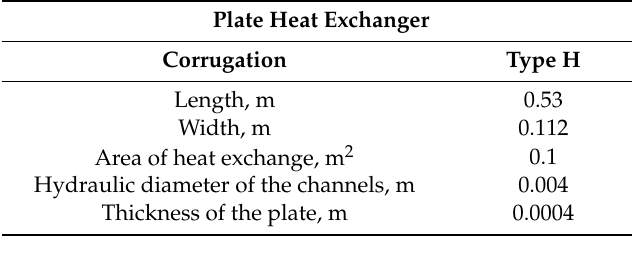
Figure 1. Scheme of the experimental equipment. Table 1. Specifications of the plate heat exchanger (PHE).